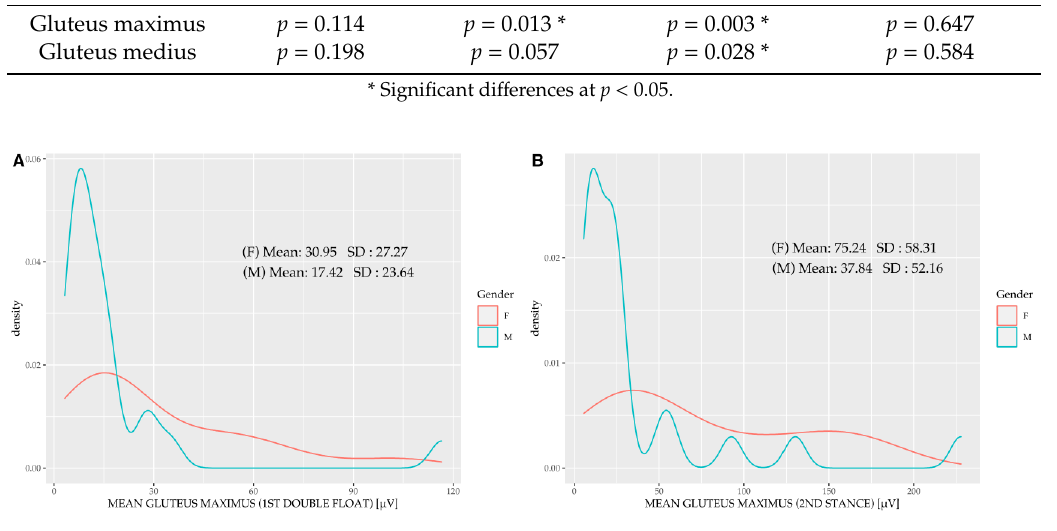
Figure 4. Variation by sex in the gluteus maximus in the first double float ( A ) and second stance ( B